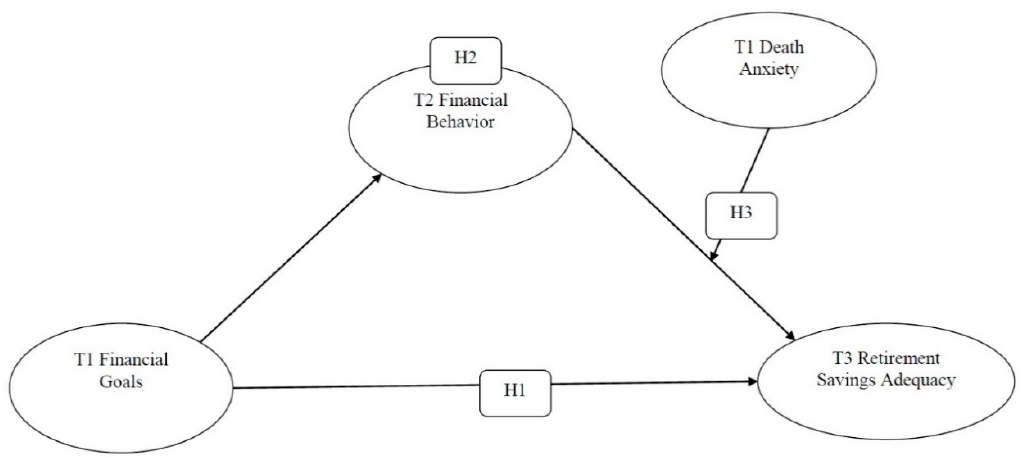
Figure 1. Theoretical model for the Study (Model 14 PROCESS).